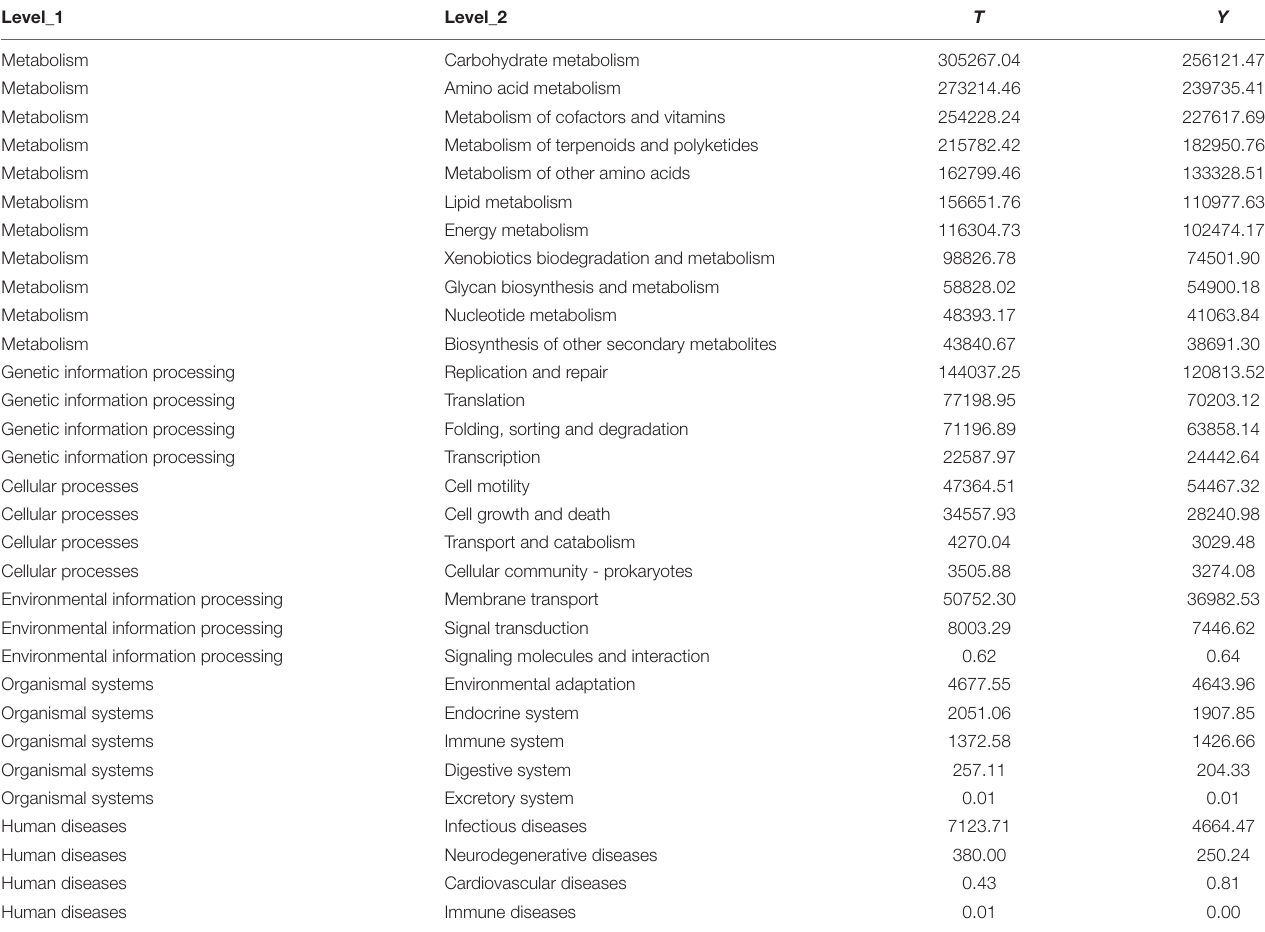
TABLE 2 | Functional prediction of colonic microbiota in Tibetan and Yorkshire